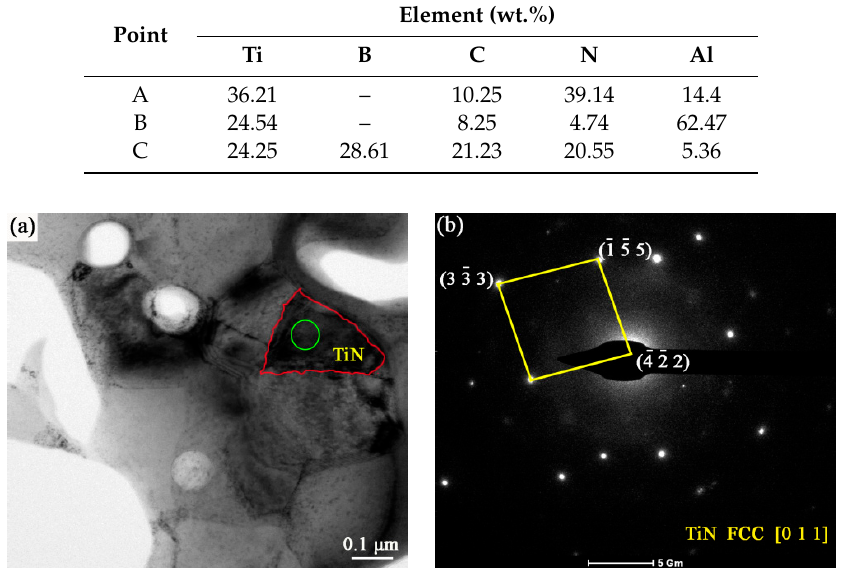
Table 3. Energy-dispersive spectroscopy (EDS) analyses (in at.%) of the typical position in Figure 11.